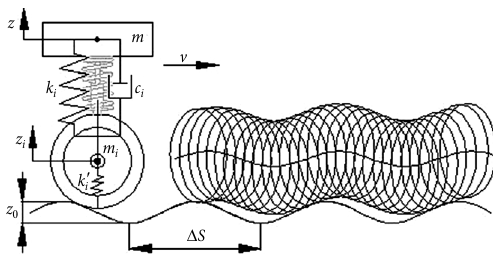
Fig. 2. Wheel model and trajectory by jumping over road